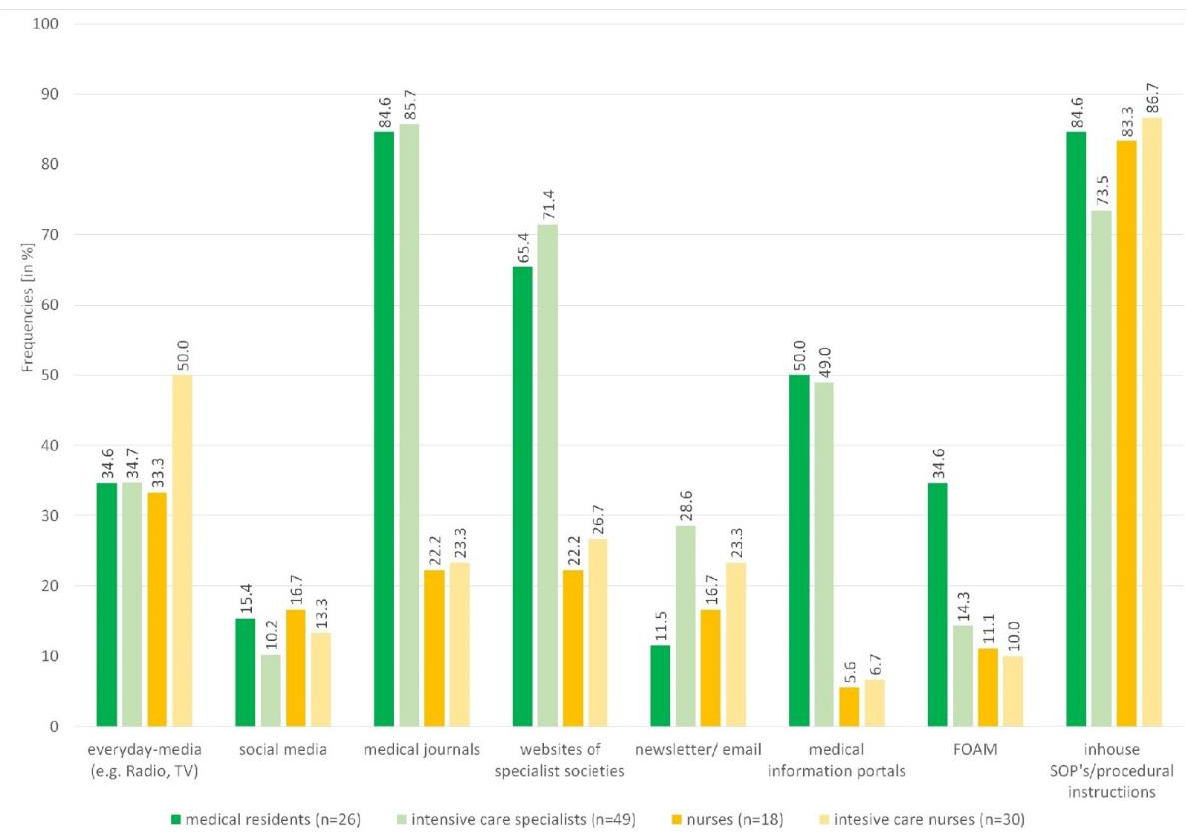
Figure 1. Use of information source according to profession. SOP standard operating procedure, FOAM free open access medical education. Median, interquartil range and percentage of usage of information sources over all